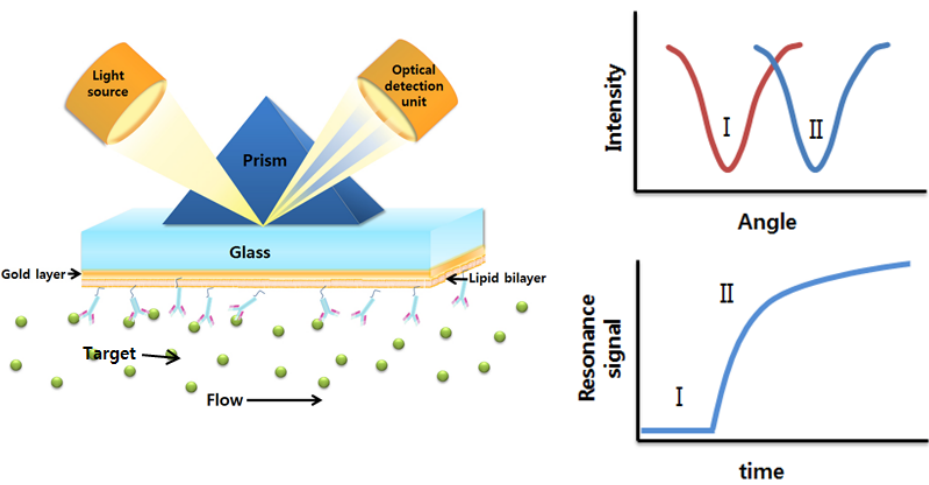
Figure 9. Schematic illustration of SPR and a typical sensorgram. A sensor chip measures the intensity of the reflection of the incident light due to the interaction between the target molecules (green spheres) in the flow solution and the probe molecules (pink